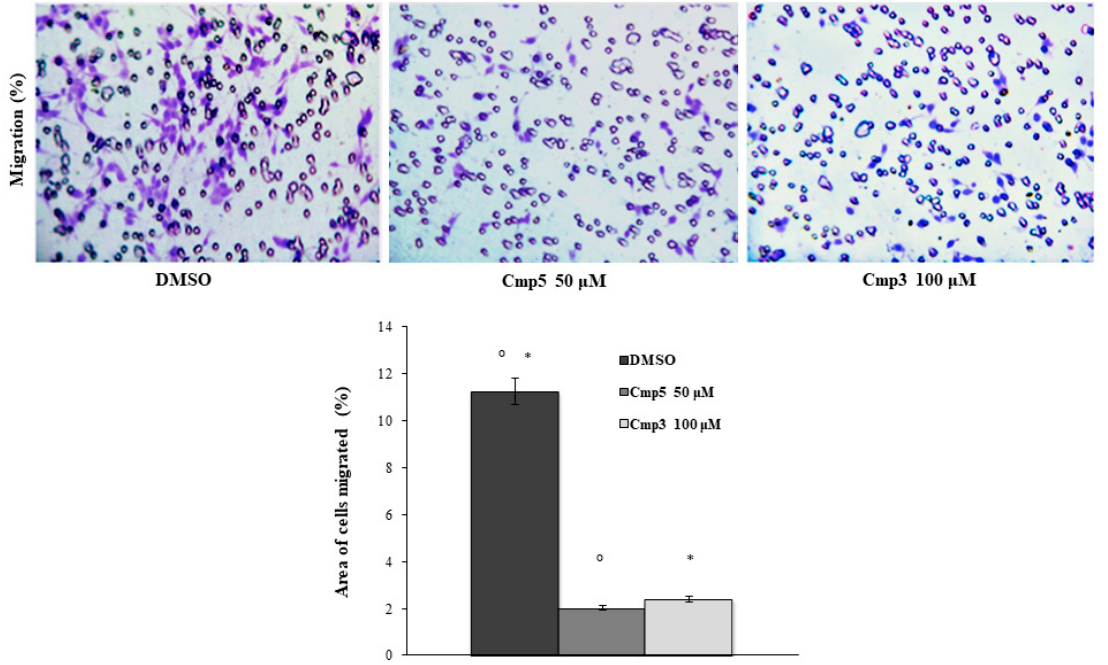
Figure 9. Transwell migration assay in C6 rat glioma cell line in the presence of Cmp 5 and Cmp 3 . Dose treatments are 50 and 100 µ M for Cmp 5 and Cmp 3 , respectively (upper panel). Histogram represents densitometric analysis determined by quantifying thresholded area for violet color in ten fields for each of three slides per sample (lower panel). Data are presented as mean ± standard deviation. Cmp 5 50 µ M versus ctrl; *Cmp 3 100 µ M versus ctrl: p < 0.0001.